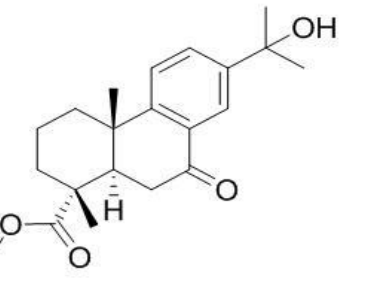
Figure 10. Allelochemicals of Pinus densiflora .